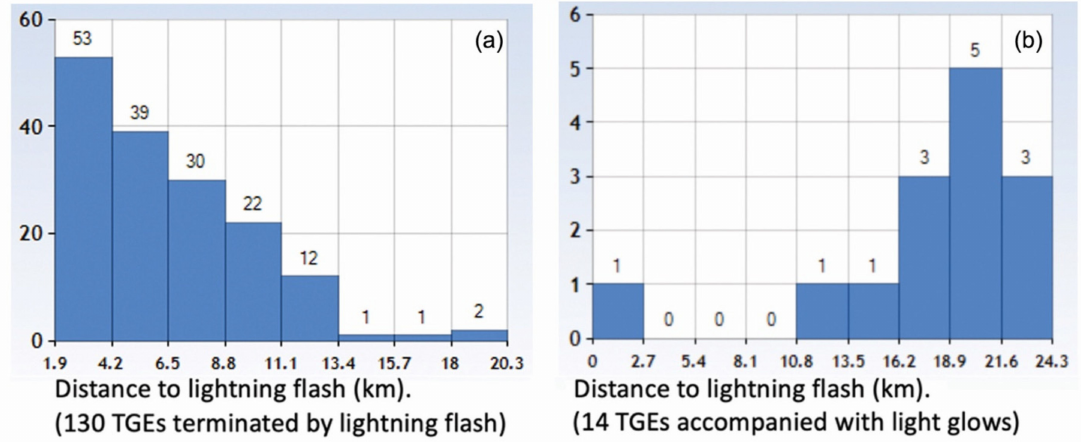
Figure 19. Distribution of the distances to the lightning flash for TGEs terminated by a flash ( a ), and for TGEs accompanied by the light glows ( b ).